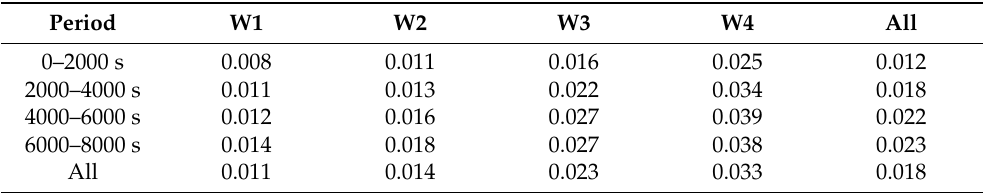
Table A4. Calculated RMSE (m) per 2000 s of iteration, per subsection of target surface in Velodyne ® HDL–32E during 30 m, day experiment. Subsections are labeled W1 through W4, with W1 being the lowest observed and W4 being the